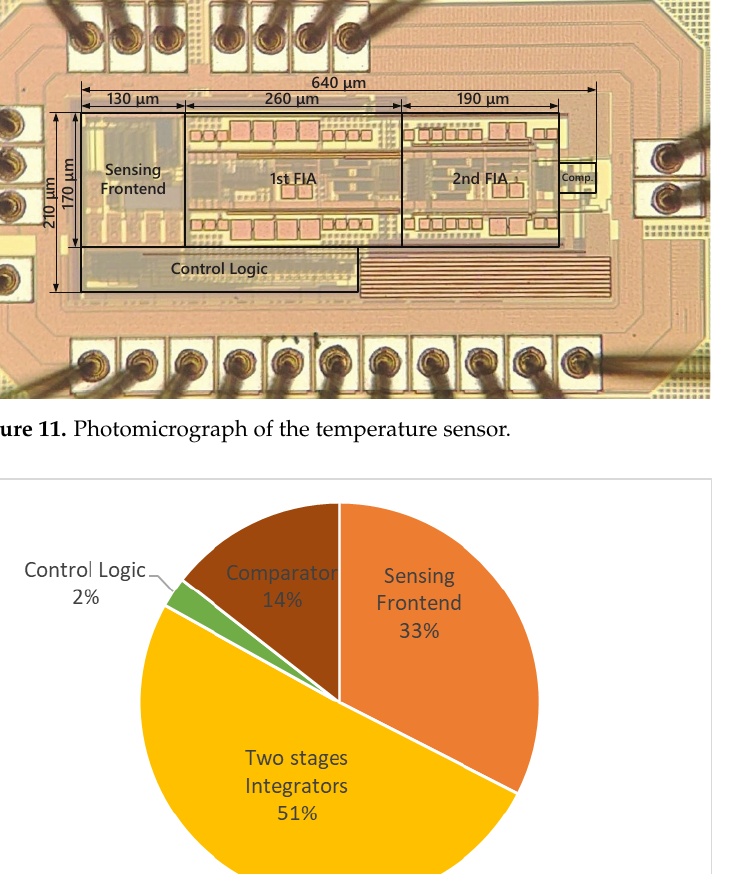
Figure 12. The supply sensitivity from 2 to 3.8 V is 0.06 ◦ C/V. The calibration logic and decimation filter are realized off-chip for flexibility.